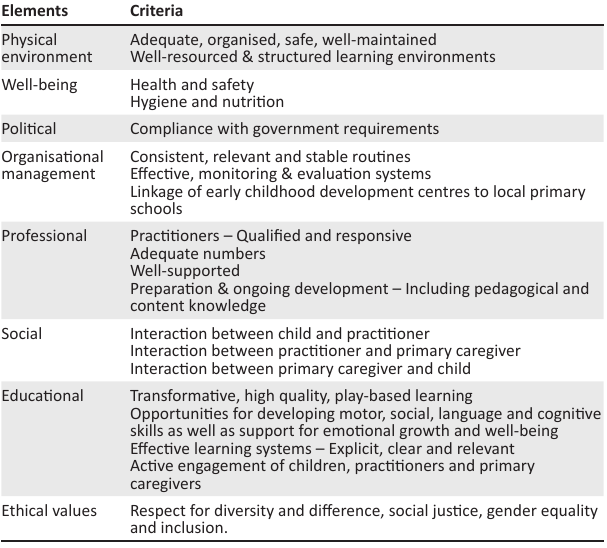
TABLE 1: Constitutive elements of quality early childhood development identified in the literature. Elements